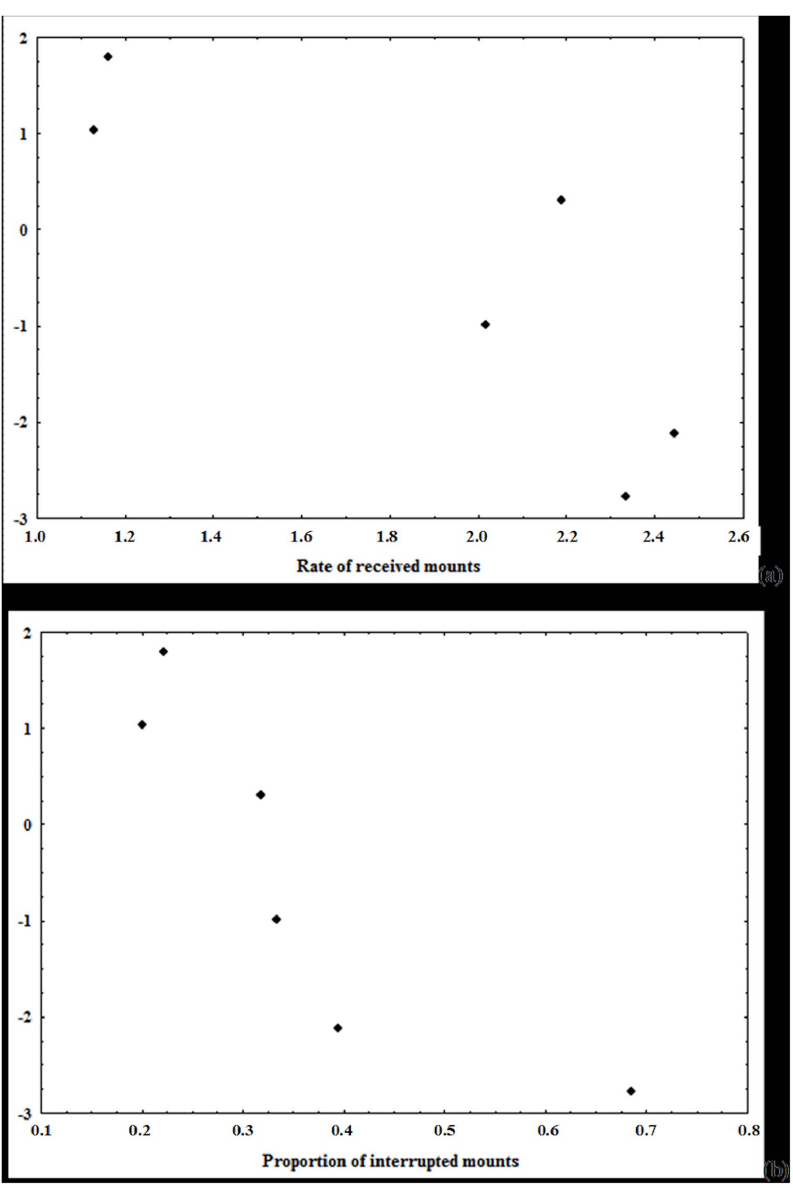
Figure 4. Correlation between the first factor PCA developed for females and: (a) rate of received mounts; (b) proportion of interrupted mounts. See text for additional